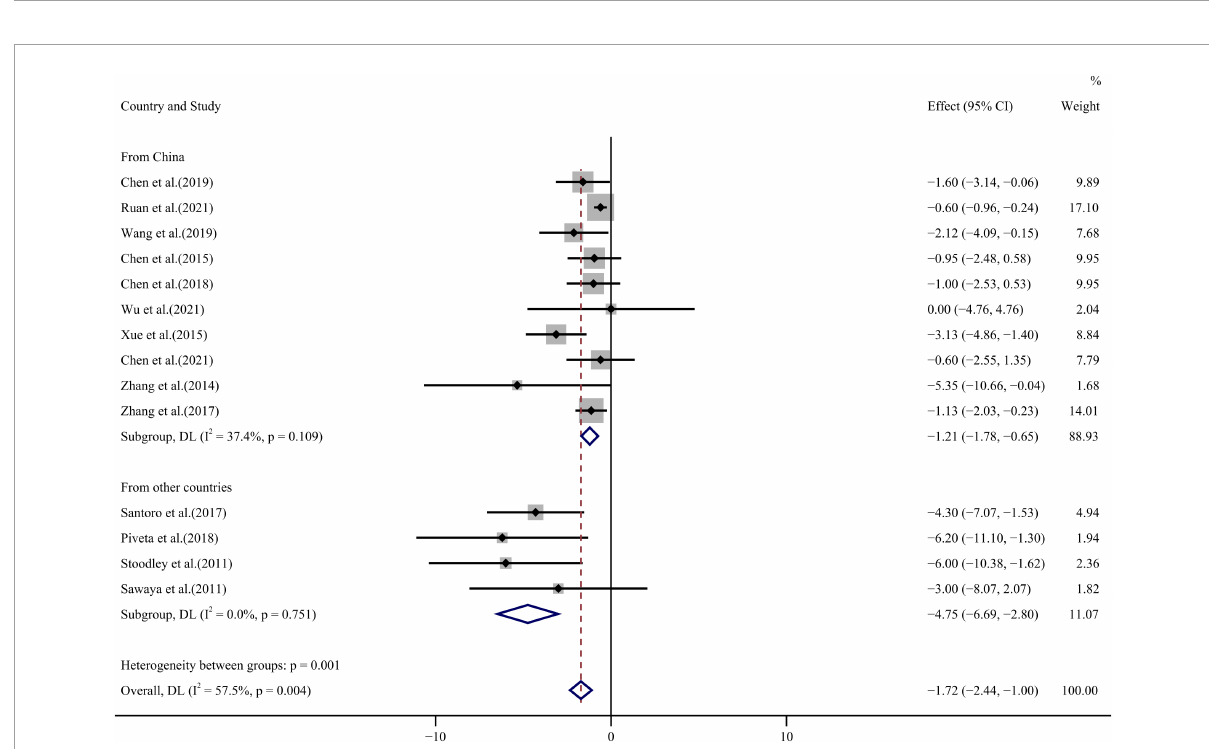
FIGURE7 GRS forest plot [Forest plot of weighted mean difference (WMD) of the association between GRS absolute value reduction and anthracyclines therapy].